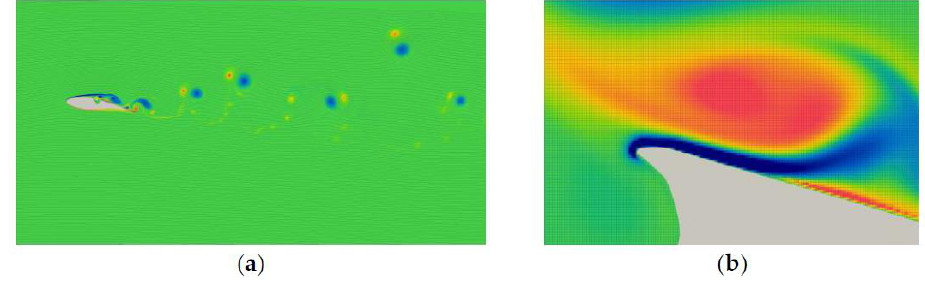
Figure 9. Numerical simulation: ( a ) Domain composition, ( b ) details of the mesh. To minimize calculation time the domain was divided into N x × N y = 48 × 24 subdo-